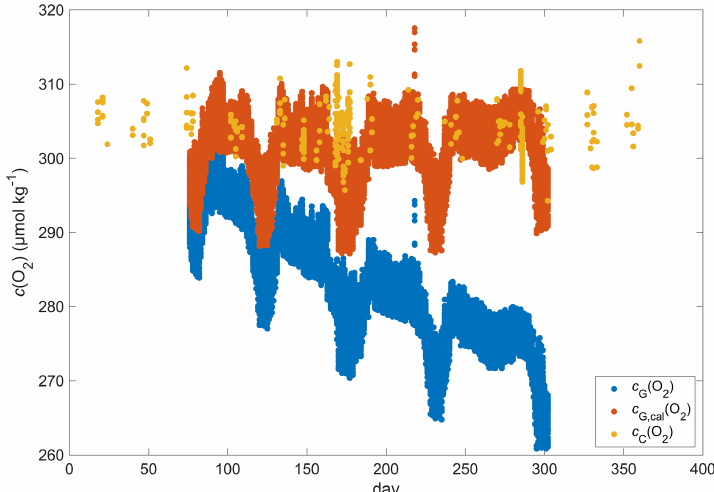
Figure A1. Discrete samples c C (O 2 ) (yellow), raw glider oxygen c G (O 2 ) (blue) and drift-corrected glider oxygen c G , cal (O 2 ) (red) for a potential density > 1028kgm − 3 at depths less than 1000m.